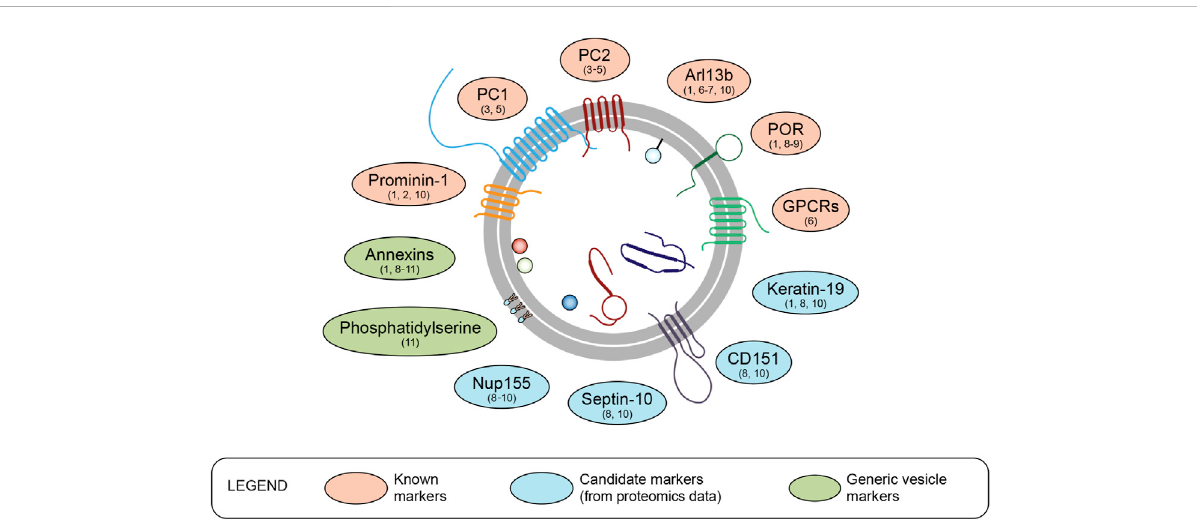
FIGURE 2 Markers and candidate markers of ciliary extracellular vesicles. With the increasing interest in ciliary EVs, the identi fi cation of speci fi c markers is needed. Although ciliary EVs are mostly large EVs (ectosomes), classical markers of large EVs are not found in ciliary EVs, except for annexins and phosphatidylserine. The cross comparison of proteomic data from the primary cilium and ciliary EVs allowed the identi fi cation of several potential markers, in addition to those already described in the literature. References: 1 Ishikawa et al., (2012), 2 Dubreuil et al., (2007), 3 Yoder et al.,